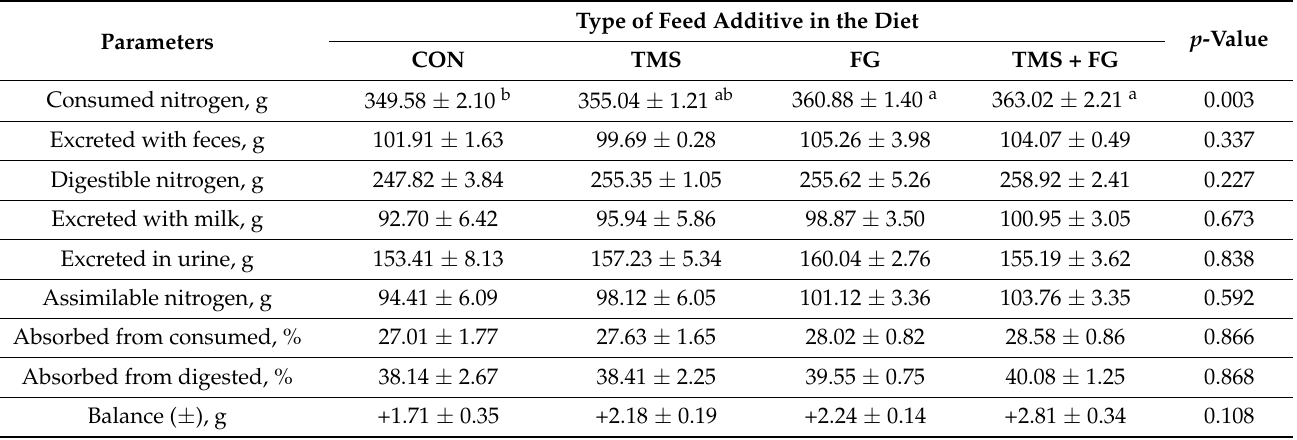
Table 6. The utilization of nitrogen by dairy cows of the Suksun breed.